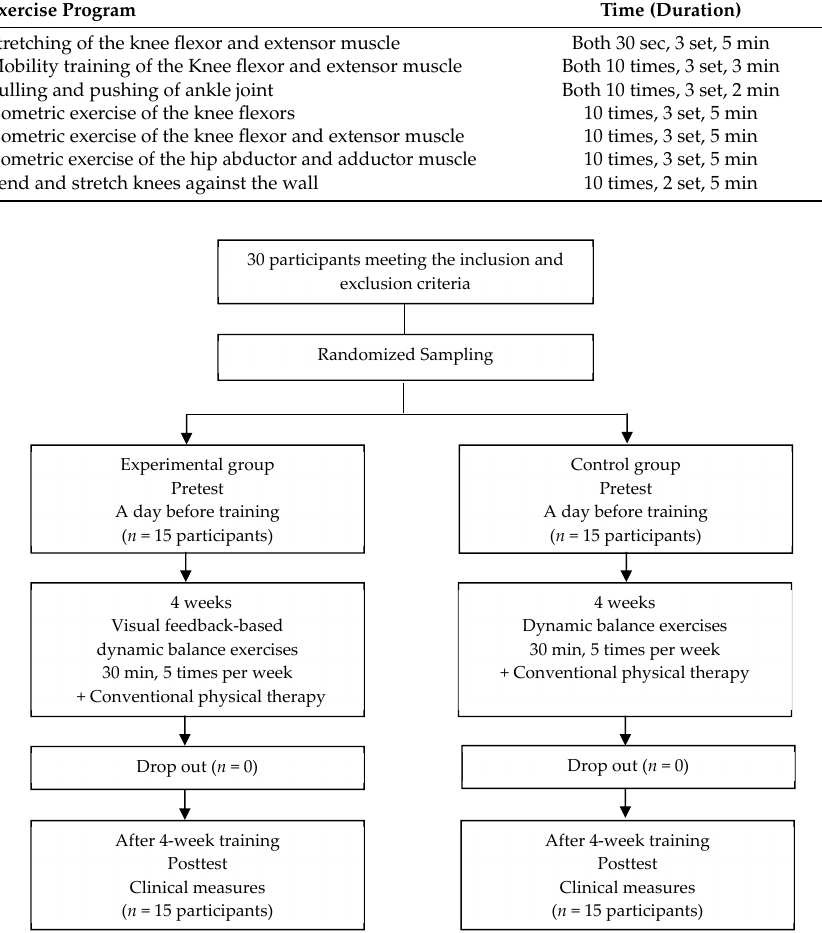
Figure 2. Flow chart of participants through the training program.